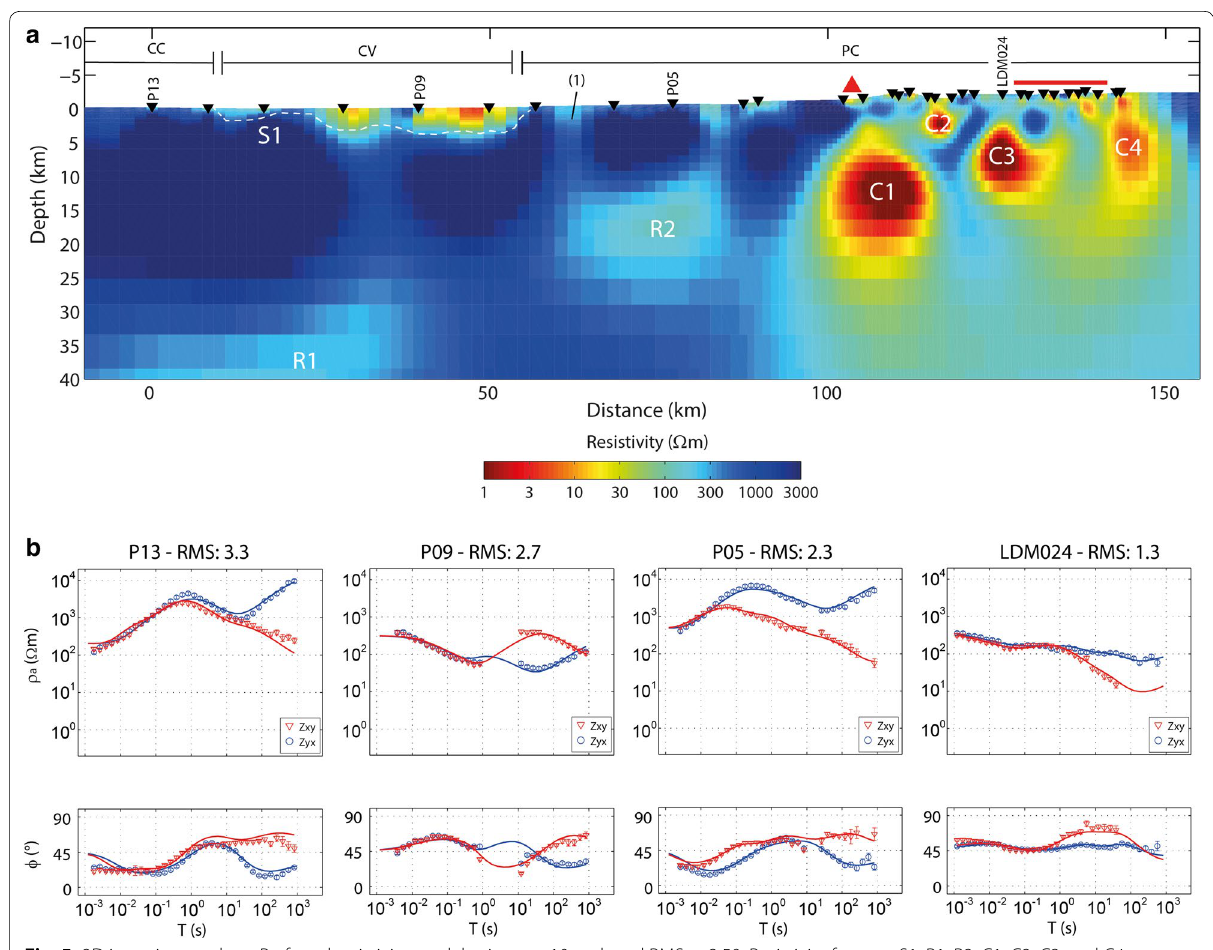
Fig. 5 2D inversion results. a Preferred resistivity model using τ 10 and total RMS 2.59. Resistivity features S1, R1, R2, C1, C2, C3, and C4 are = = explained in the text. Black triangles correspond to MT stations. Morphostructural units delimited: Coastal Cordillera (CC), Central Valley (CV) and Principal Cordillera (PC). (1) Corresponds to the same fault shown in Fig. 1. The TSP complex is represented by a red triangle and the LdM complex by a red rectangle. b Apparent resistivity, phase and model response for several